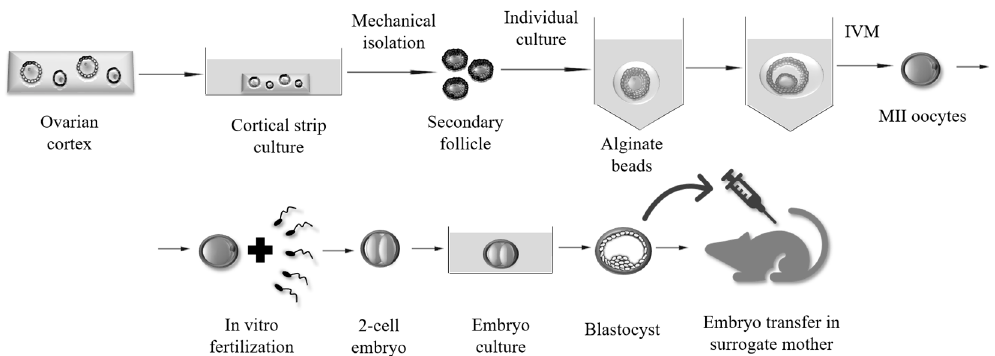
Figure 3. Schematic representation of multi-step culture. Primordial follicles are cultured in ovarian cortex to antral stage. Preovulatory oocytes undergo in vitro maturation (IVM). Metaphase II oocytes (MII) are in vitro fertilized and embryos transferred to surrogate mothers.